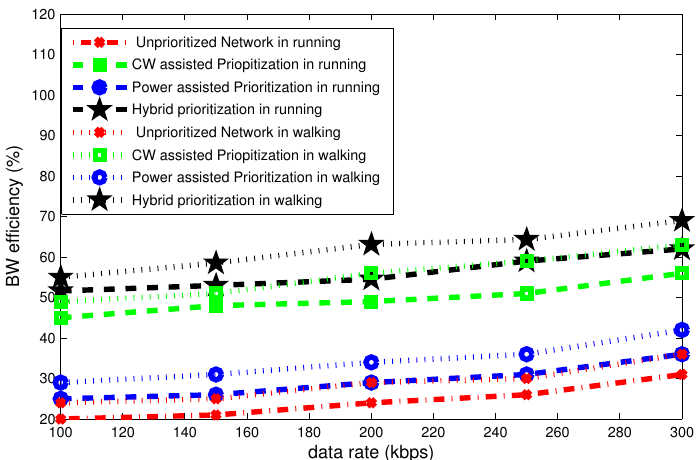
Figure 22. Effect of data rate on bandwidth efficiency in mobile